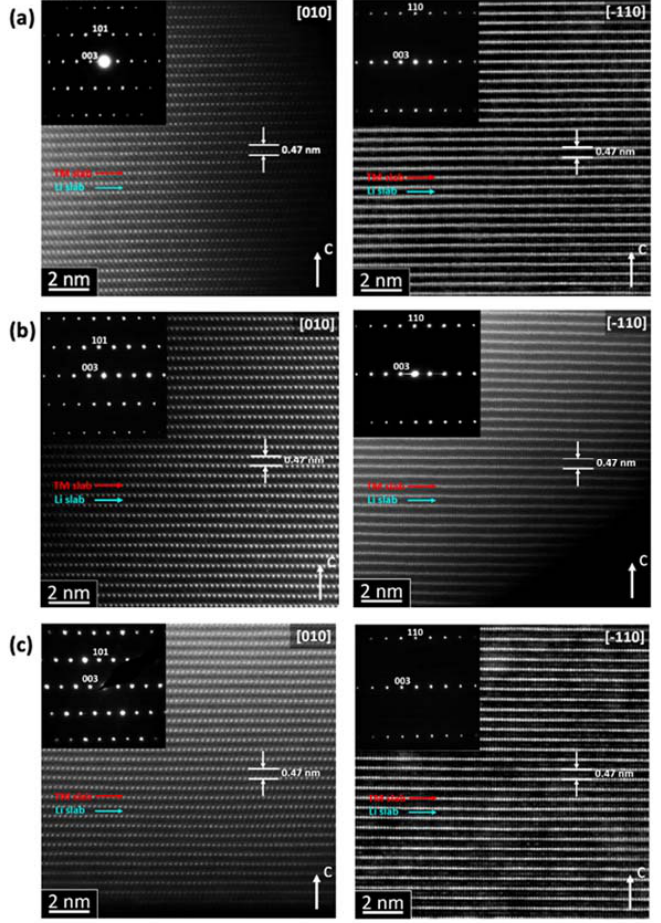
Figure 7. [010] and [ 1(cid:3364) 10] HAADF-STEM images along with the corresponding SAED patterns